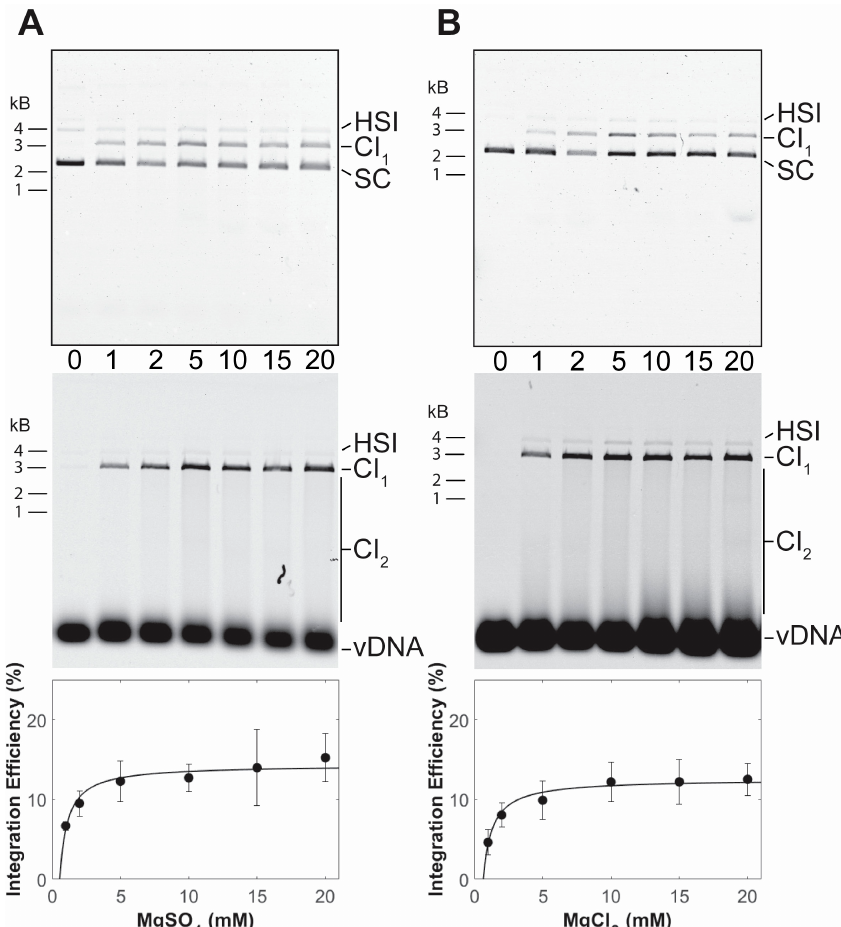
Figure 2. PFV intasome integration in the presence of Mg. Integration activity was assayed with a titration of ( A ) MgSO 4 or ( B ) MgCl 2 . Reaction products were resolved by agarose gel electrophoresis. The gel was imaged for ethidium bromide (top) and Cy5 (center) fluorescence. Half site integration (HSI), the first concerted integration product (CI 1 ), and subsequent concerted integration products (CI 2 ) are shown. Unreacted supercoiled plasmid target DNA (SC) is visible on in the ethidium bromide image. Unreacted vDNA is only visible in the Cy5 image. The total Cy5 fluorescence in each lane was quantified and each integration product calculated as the fraction of the total fluorescence (bottom). The average of three independent experiments with at least two independent intasomes preparations is shown. Error bars indicate the standard deviation.